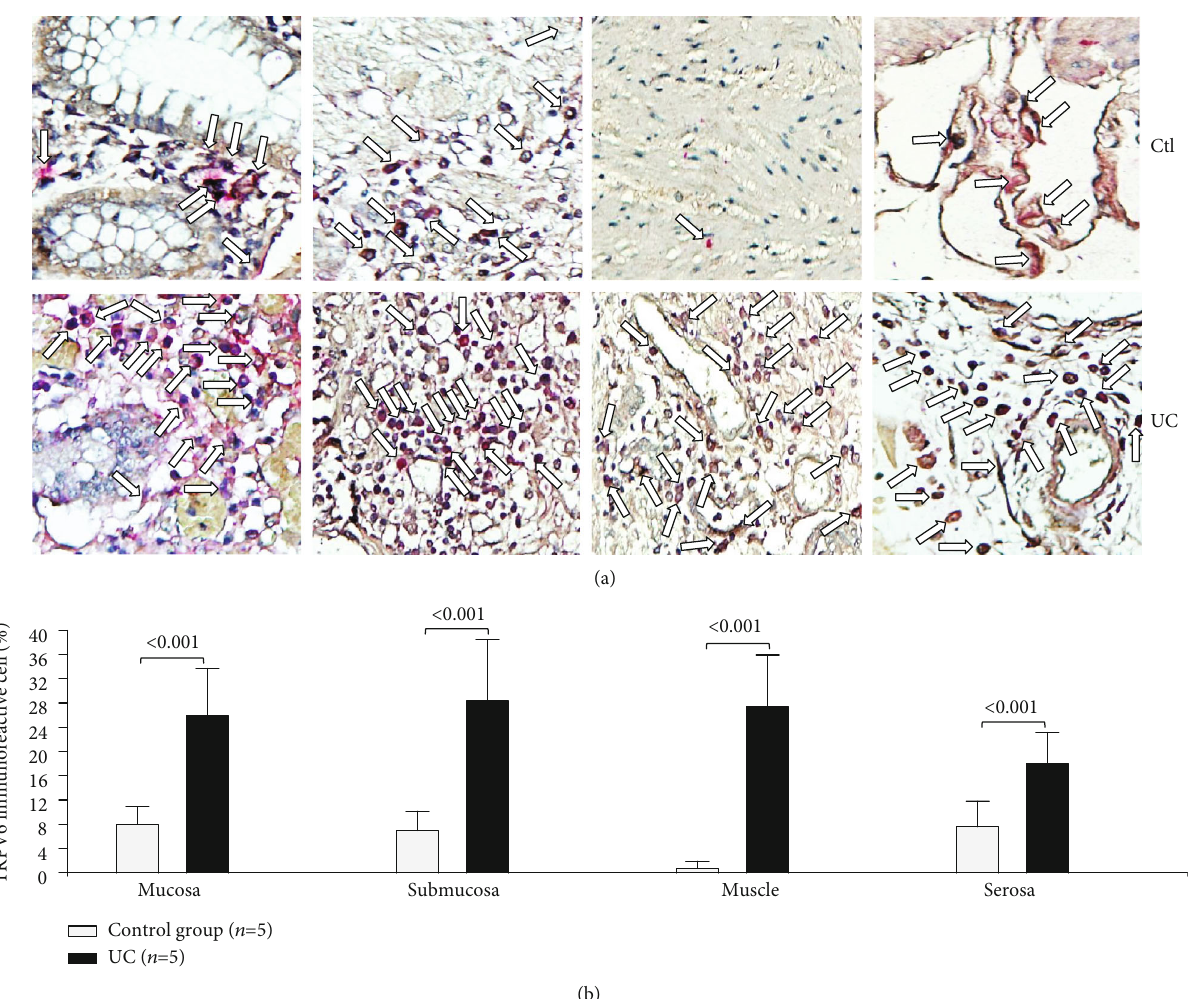
Figure 6: Protein expression of TRPV6 in intestinal tissue from patients with UC and controls. TRPV6 protein expression in slides with colonic tissue obtained from patients with severe ulcerative colitis and nonin fl amed colonic tissue. (a) Immunoperoxidase photomicrographs of ulcerative colitis (lower panel, n = 5 ) and non-IBD colonic tissue (control; upper panel, n = 5 ). Arrows indicate TRPV6 immunoreactive cells in the mucosa, submucosa muscular, and serosa layers. Original magni fi cation was × 320. (b) TRPV6-producing cell percentage in nonin fl amed colonic tissues (control, n = 5 ) and active UC patients ( n = 5 ) is shown in